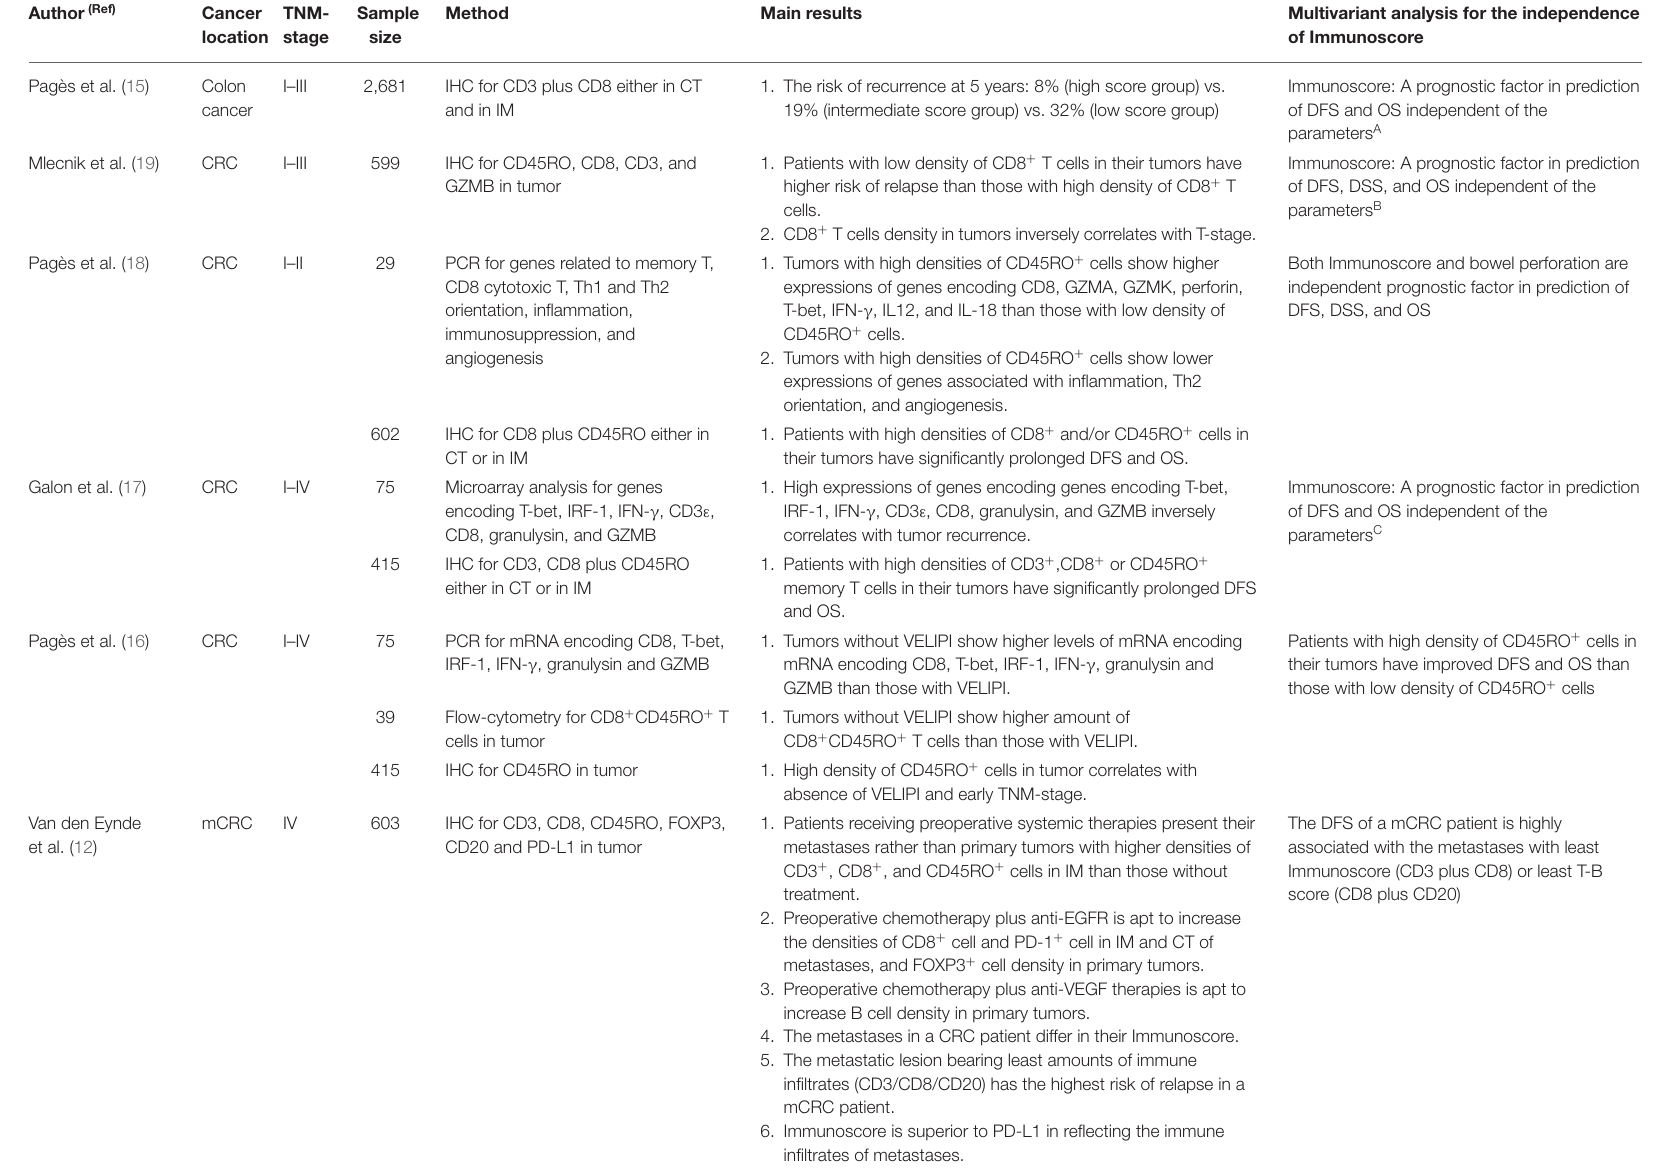
TABLE 1 | Landmark studies indicating the value of Immunoscore in predicting CRC